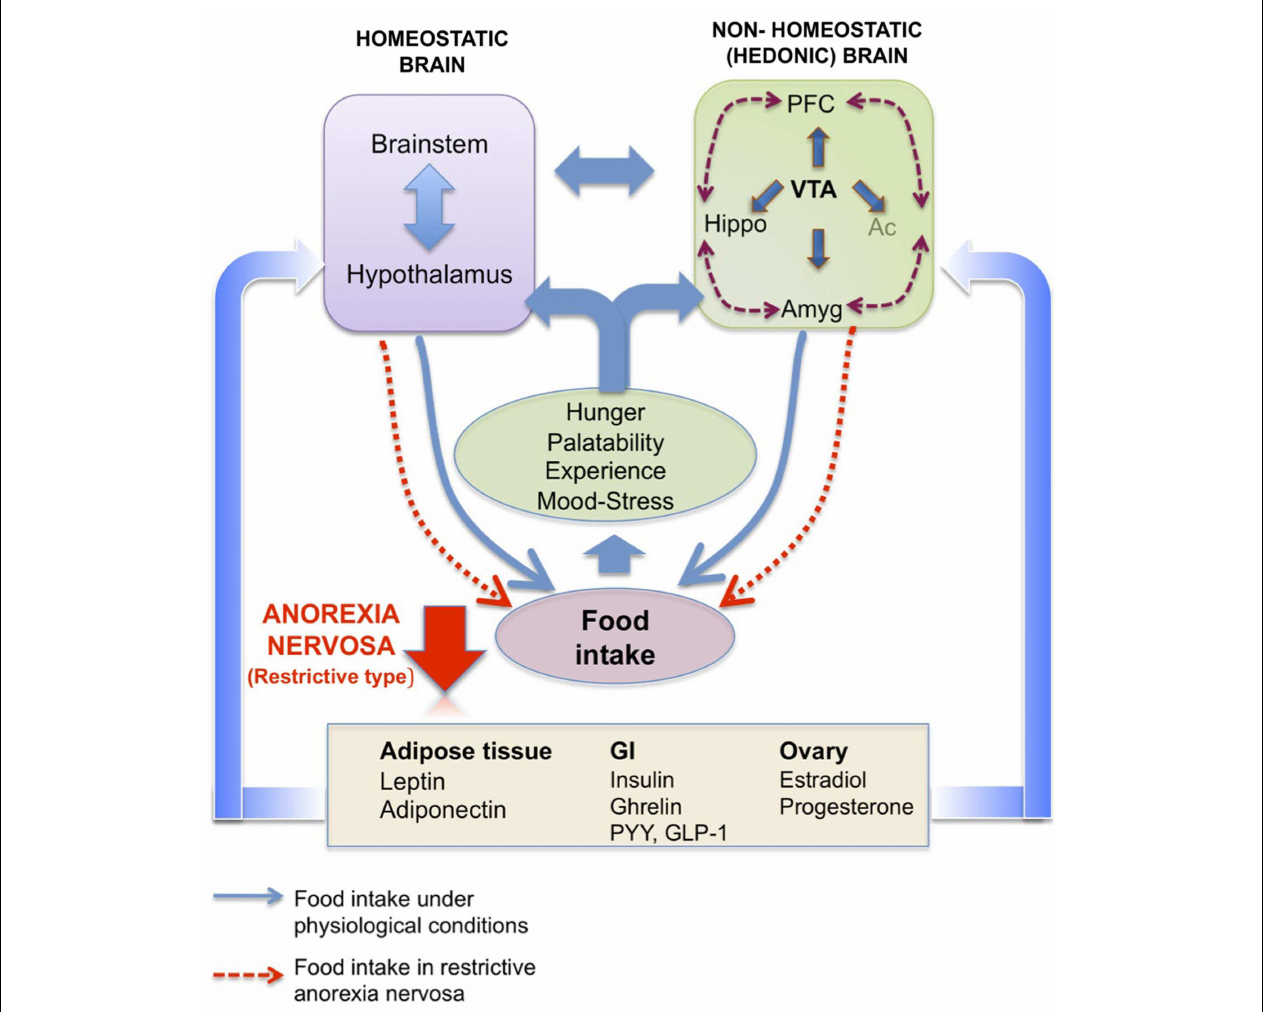
tissue, gastrointestinal tract or ovary reach these areas, directly or indirectly to activate pathways controlling both energy balance (homeostatic brain) and pleasure (hedonic brain) associated with eating (hunger level, palatability of the food, past experiences, mood, level of stress). In anorexia nervosa (restrictive type), a deregulation of one or more of these pathways as well as the cross-talk between periphery and brain might be considered. Adapted fromVanVugt